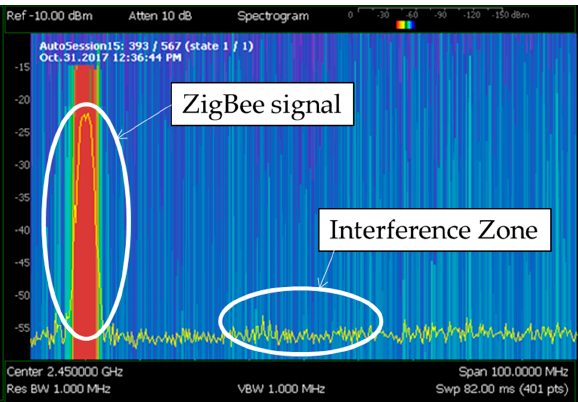
Figure 9. Measured spectrogram at 2.4 GHz band in the middle of the scenario with the XBee mote transmitting 10 dBm at ZigBee channel C (2.41 GHz).